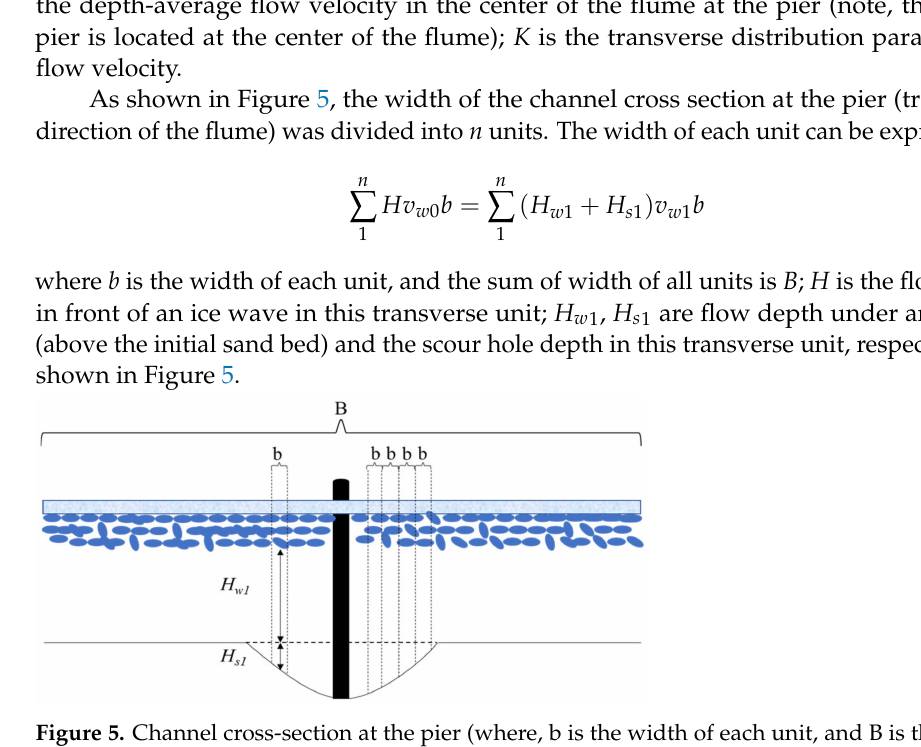
Figure 5. Channel cross-section at the pier (where, b is the width of each unit, and B is the sum of width of all